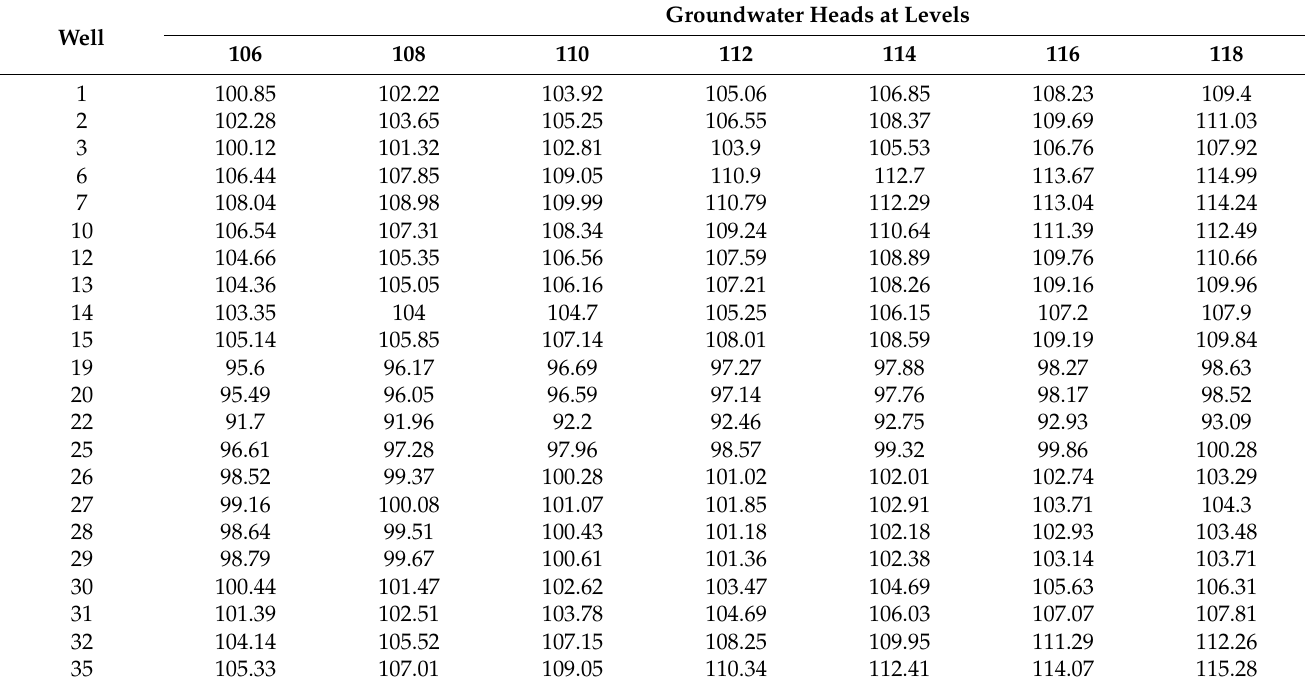
Table 3. Prediction GWL and observation well number at different boundary